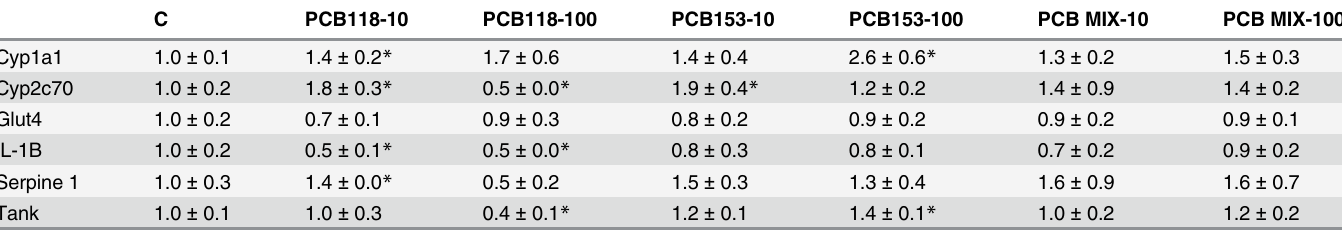
Table 11. Real-time RT-PCR validation of genes selected within the colon after microarray analyses ( * p <